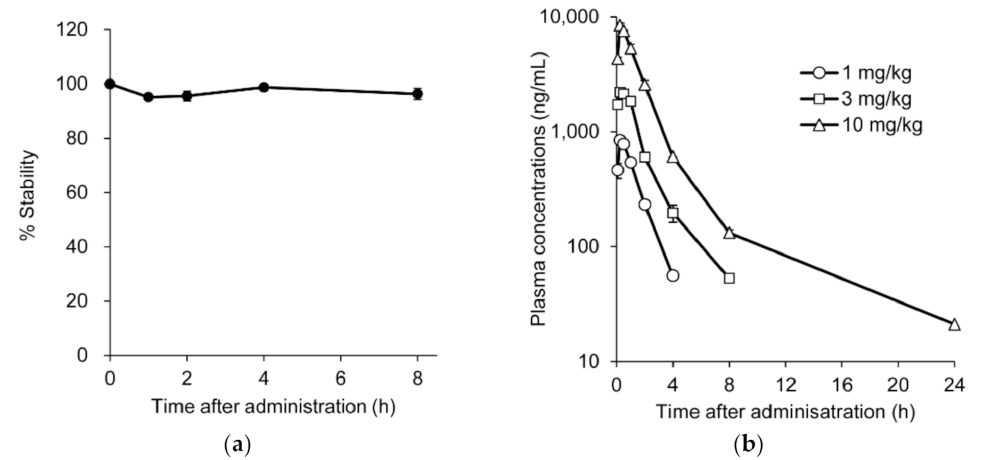
Figure 3. Stability and pharmacokinetics of renadirsen in mouse blood. ( a ) Stability of renadirsen in mouse blood was analyzed using an LC-MS/MS system, and peak area ratio (renadirsen/IS) was determined. The data at each time point are expressed as stability %, with peak area ratio at 0 min being 100%. ( b ) Pharmacokinetics of renadirsen sodium in mdx mice after its single subcutaneous injection at doses of 1, 3, and 10 mg/kg, analyzed using LC-MS/MS. Blood samples were collected 5, 15, and 30 min, and 1, 2, 4, 8, and 24 h after administration. Data in ( a ) and ( b ) are shown as means ± SD; n =